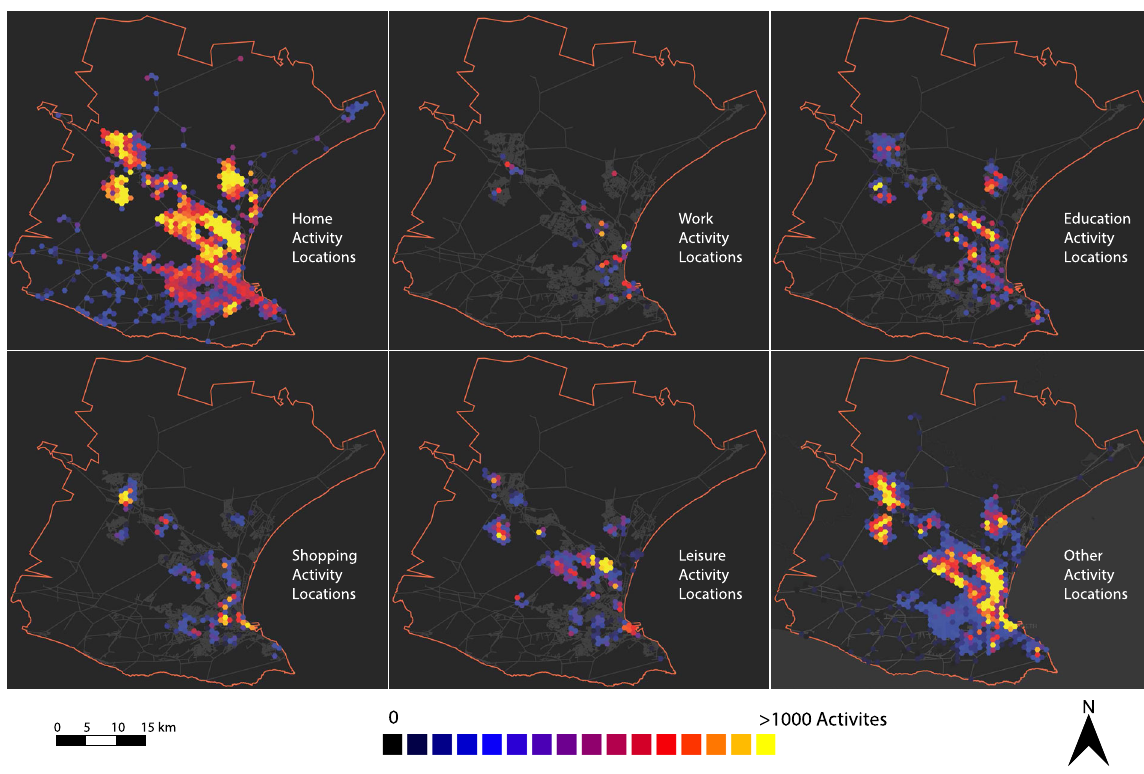
Fig. 3 Aggregation analysis of the activity locations in the simulation model. The colour of the hexagonal grid depicts the absolute number of activities taking place within the aggregated raster, ranging from no activities (black colour) to over 1000 activities (yellow colour). A grid size of 500 m and linear scaling is employed.